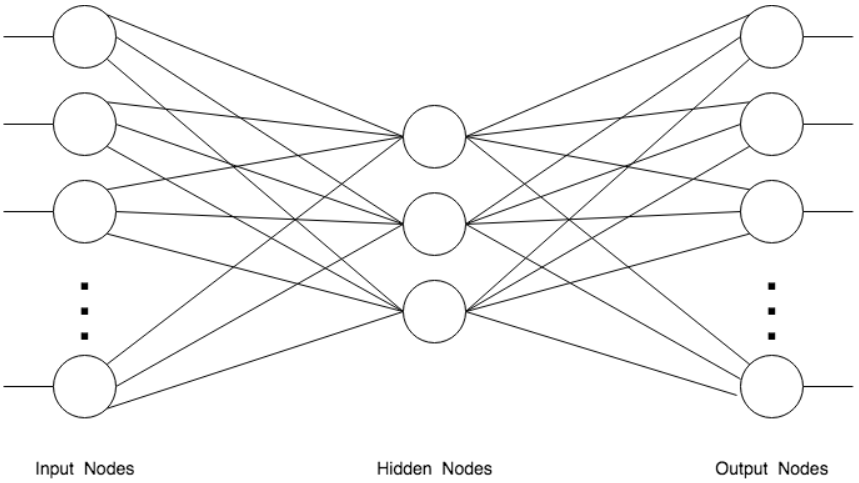
Figure 6. Autoencoder architecture: input and output have the same